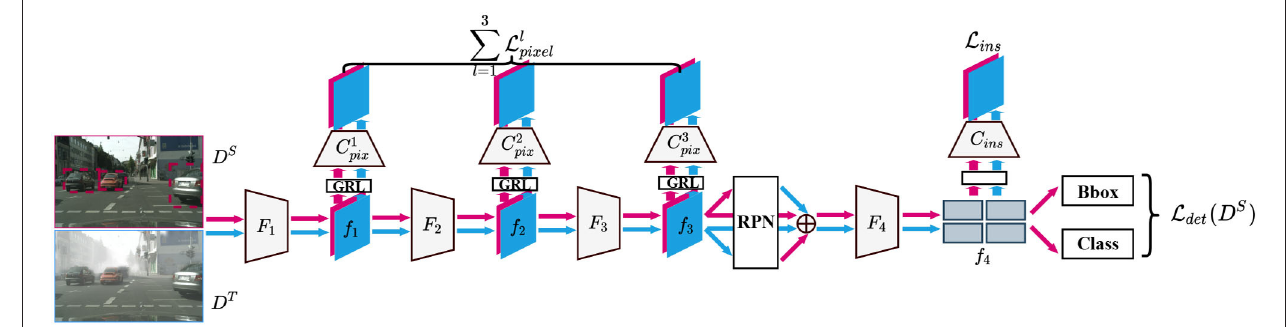
FIGURE 2 | Overview of single-step domain adaptive model. The pink color represents the source domain, while the blue represents the target. This structure has three pixel-level domain discriminators ( C 1 pix to C 3 pix ) and one instance-level discriminator ( C ins